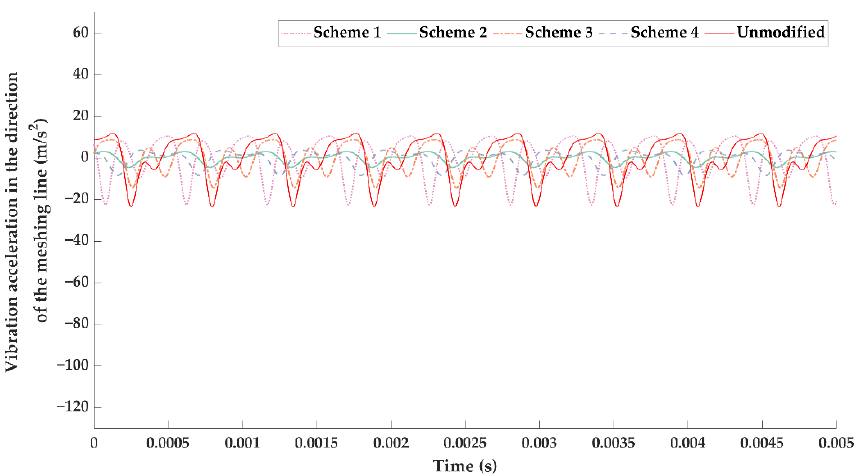
Figure 24. Vibration acceleration in the direction of the gear meshing line at a load of 300 N·m.